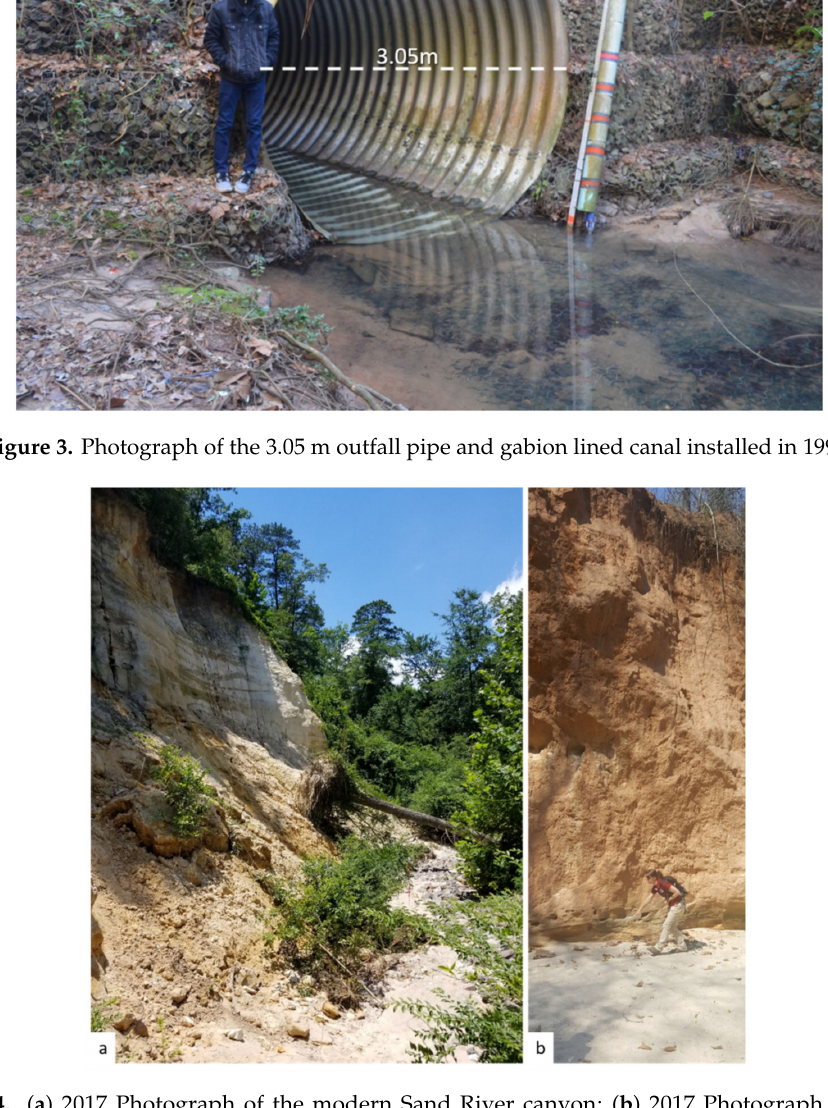
Figure 4. ( a ) 2017 Photograph of the modern Sand River canyon; ( b ) 2017 Photograph showing undercutting of the banks due to active channel flows increases instability of the channel banks, leading to frequent bank